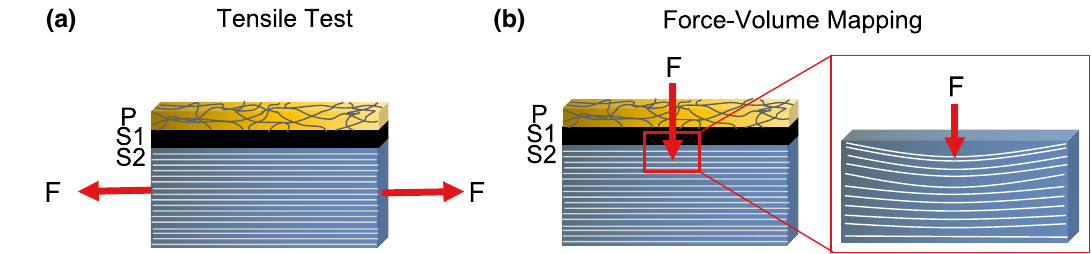
volume mapping, the fibrils of the S2 layer are oriented perpendic- ular to the applied force. Thus, the fibrils from the S2 layers can be locally bent as shown in figure ( a )